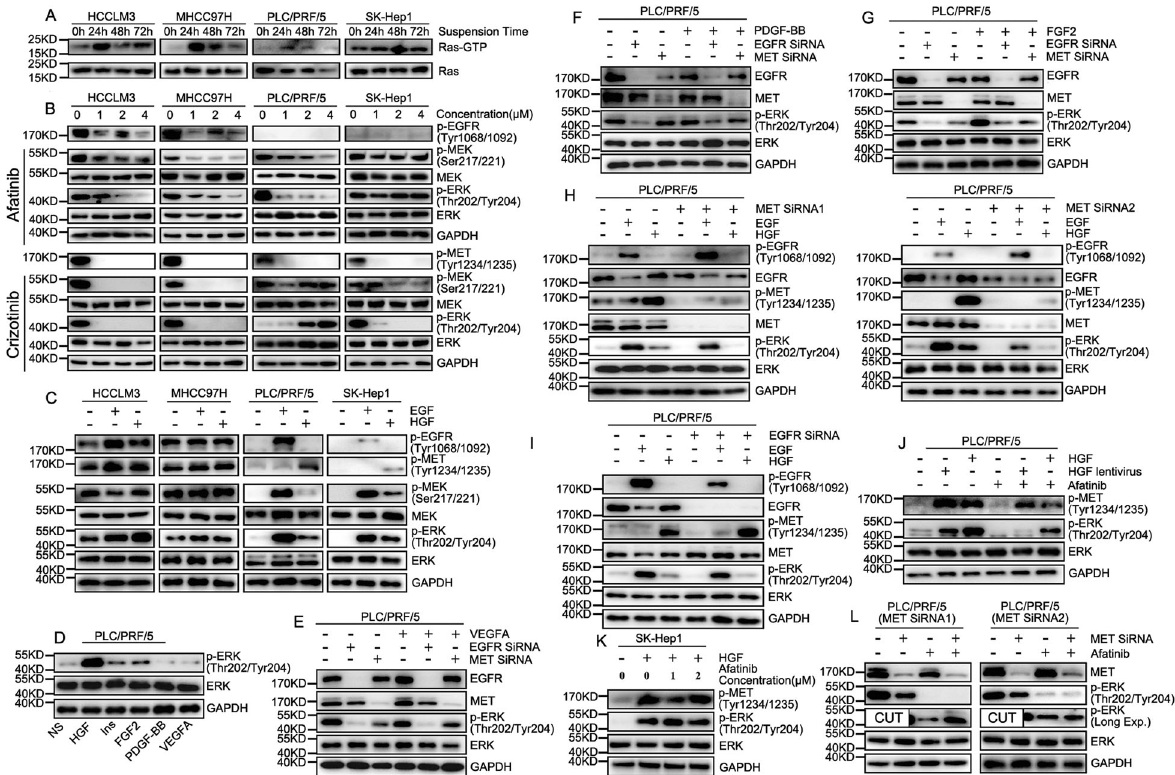
Fig. 4 EGFR/MET were powerful in regulation of Ras/MAPK pathway based on high expression. A Ras Activation Assay Kit was used for detection of Ras-GTP in suspended HCC cell lines. Low concentration of suspended HCC cells was prevented from cluster formation and used for detection of Ras activation in 0, 24, 48 and 72 h. B Western Blot was used to con fi rm the regulation of EGFR/MET in Ras/MAPK pathway, including sensitivity of Ras/MAPK pathway to EGFR/MET inhibitors and C EGF/HGF in activation of Ras/MAPK pathway in different HCC cell lines. D 50 ng/ml of recombined ligands was used for RTKs phosphorylation and cells were harvested after 1 h for comparing activation of Ras/ MAPK pathways. ( E ) VEGF, ( F ) PDGF-BB and ( G ) FGF2 were veri fi ed in restoration of Ras/MAPK pathway activation in PLC/PRF/5 cell line with EGFR/MET knock-down. H EGF/HGF was detected in activation of Ras/MAPK pathway of PLC/PRF/5 with MET knock-down and I EGFR knock- down. J Western Blot showed the effect of EGFR on MET down-regulation in EGFR inhibitor in PLC/PRF/5 cell line with exogenous/ endogenous HGF stimulation. K EGFR inhibitor was used in detection of MET inhibition in SK-Hep1 cell line, which is not sensitive to EGFR inhibitor. L Effect of EGFR inhibitor was veri fi ed on PLC/PRF/5 cell line with MET